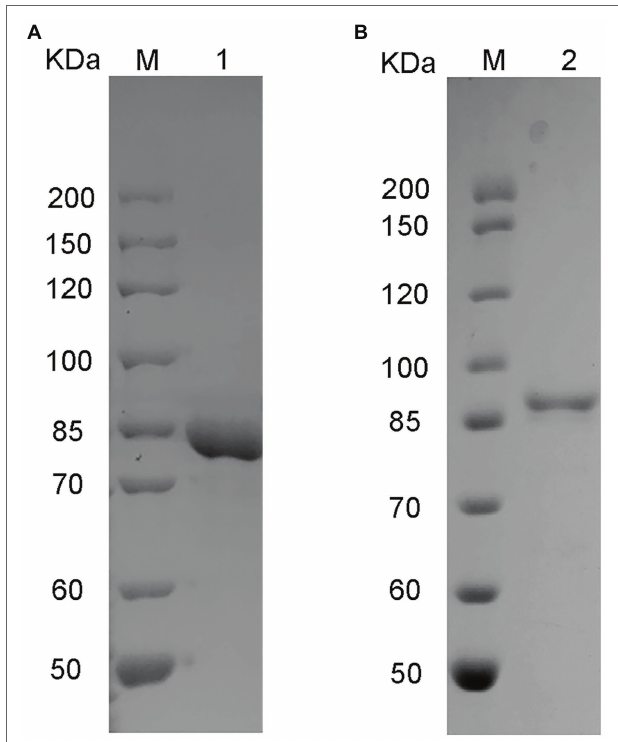
FIGURE 5 | Sodium dodecyl sulfate-polyacrylamide gel electrophoresis (SDS-PAGE) of purified recombinant VaHly8A (A) and VaHly8B (B) . Lane M, unstained protein molecular weight marker; lane 1, purified VaHly8A; and lane 2, purified